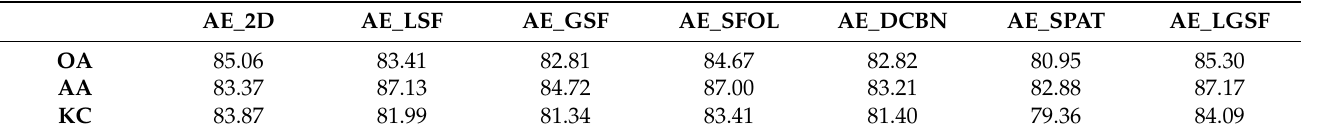
Table 10. Classification results of ablation experiments on the Houston 2013 dataset. (shown in %).